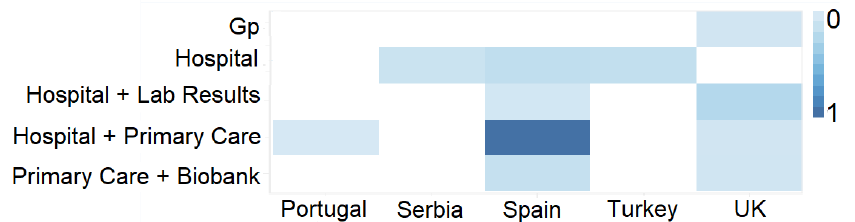
Figure 7. UI mockup proposal of a heat map